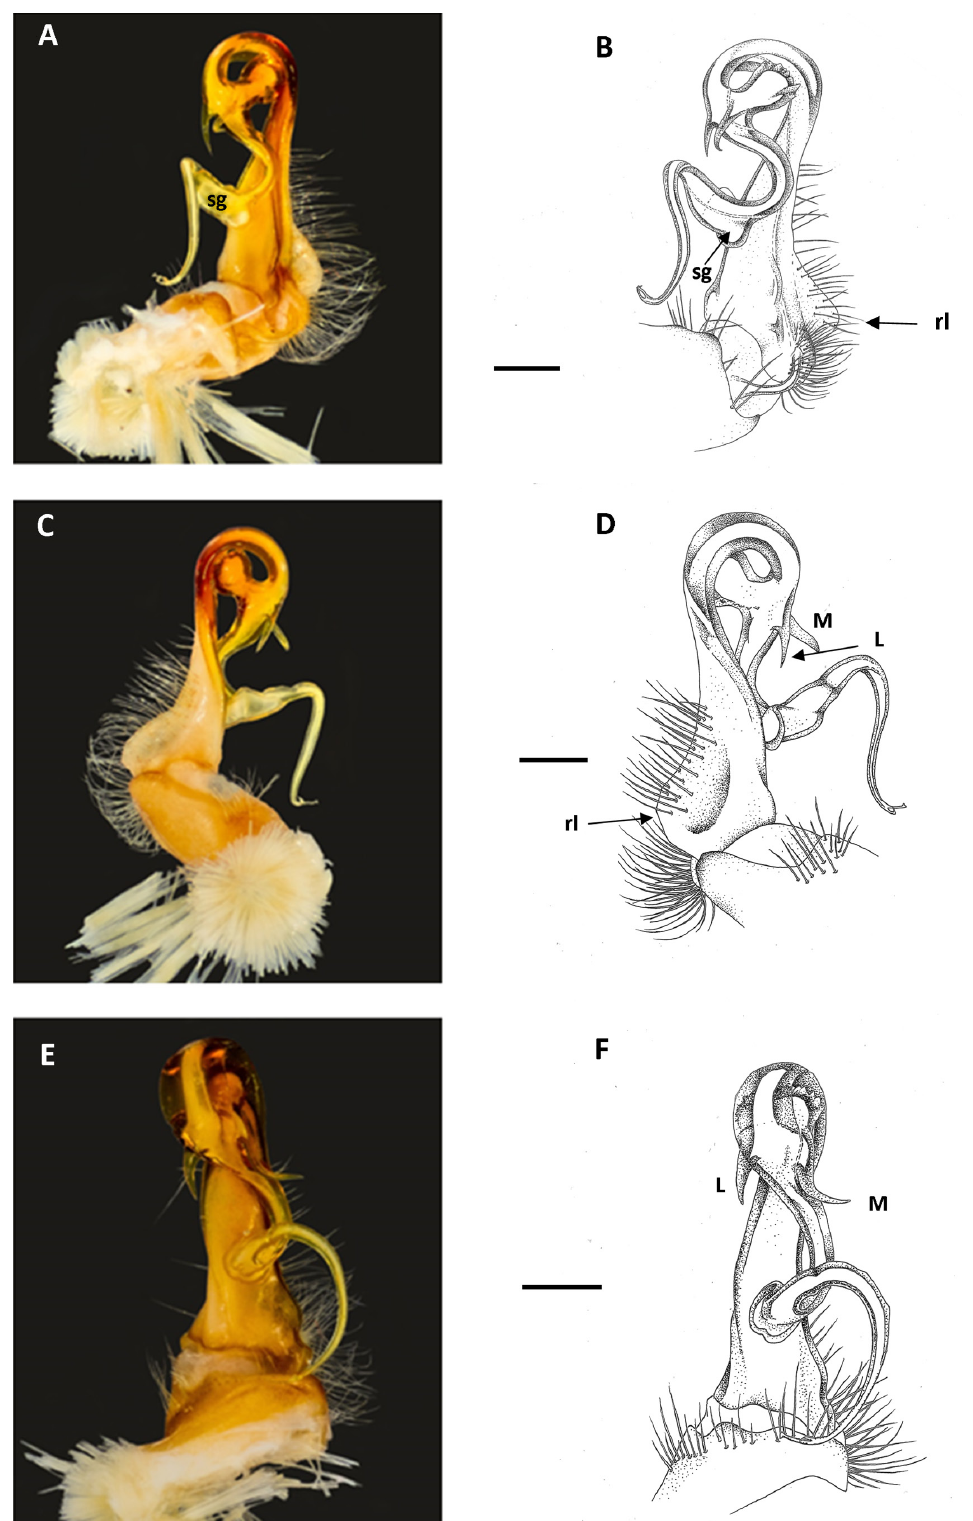
Fig. 17. Emphysemastix frampt Olsen & Enghoff sp. nov., holotype, ♂ (NHMD 621677), left gonopod. A–B . Mesal view. C–D . Lateral view . E–F . Dorsal view. Abbreviations: L = Process L; M = Process M; rl = rounded lobe; sg = subglobose enlargement. Scale bars: 1